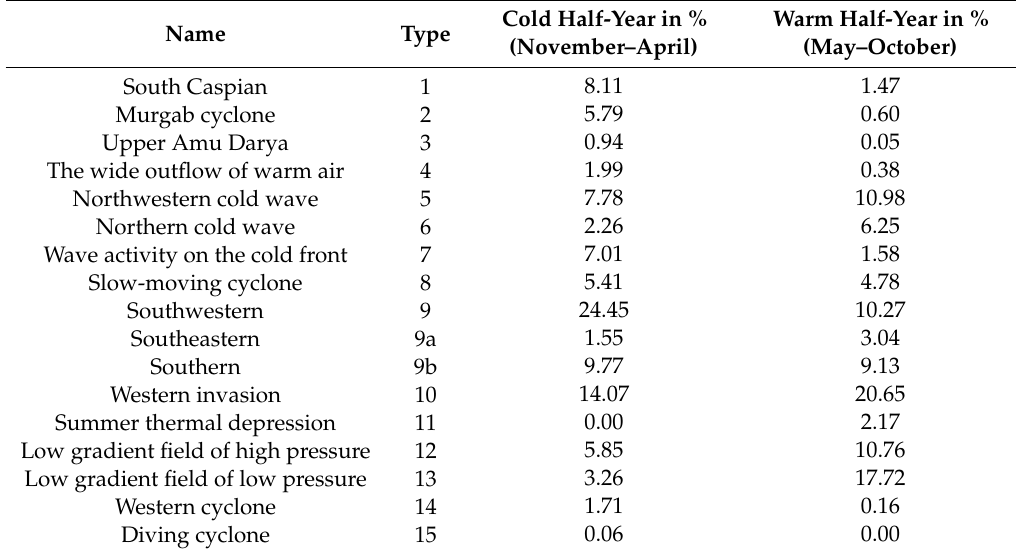
Table 1. Classification of SWT over Middle Asia during the warm and cold half-year in the percentage of days over 1961–1990